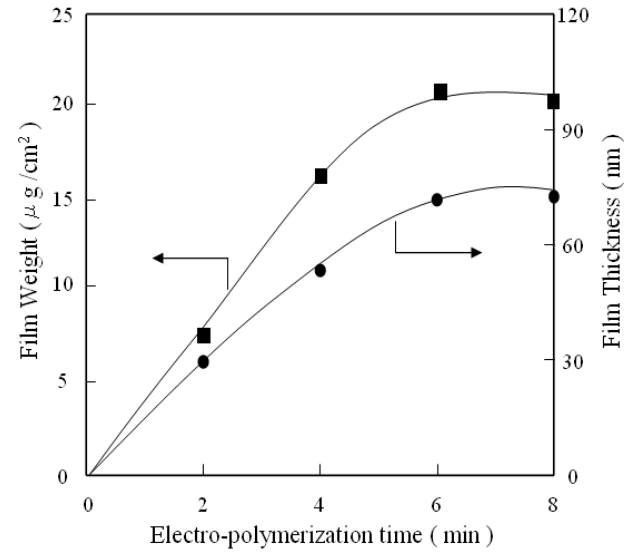
Figure 3. Effect of electrochemical polymerization time on the film weight and film thickness.